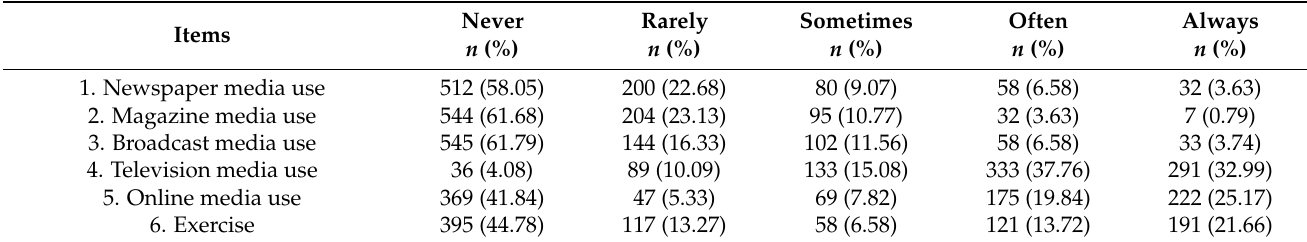
Table 2. Descriptive statistics of participants’ media use and exercise ( n =